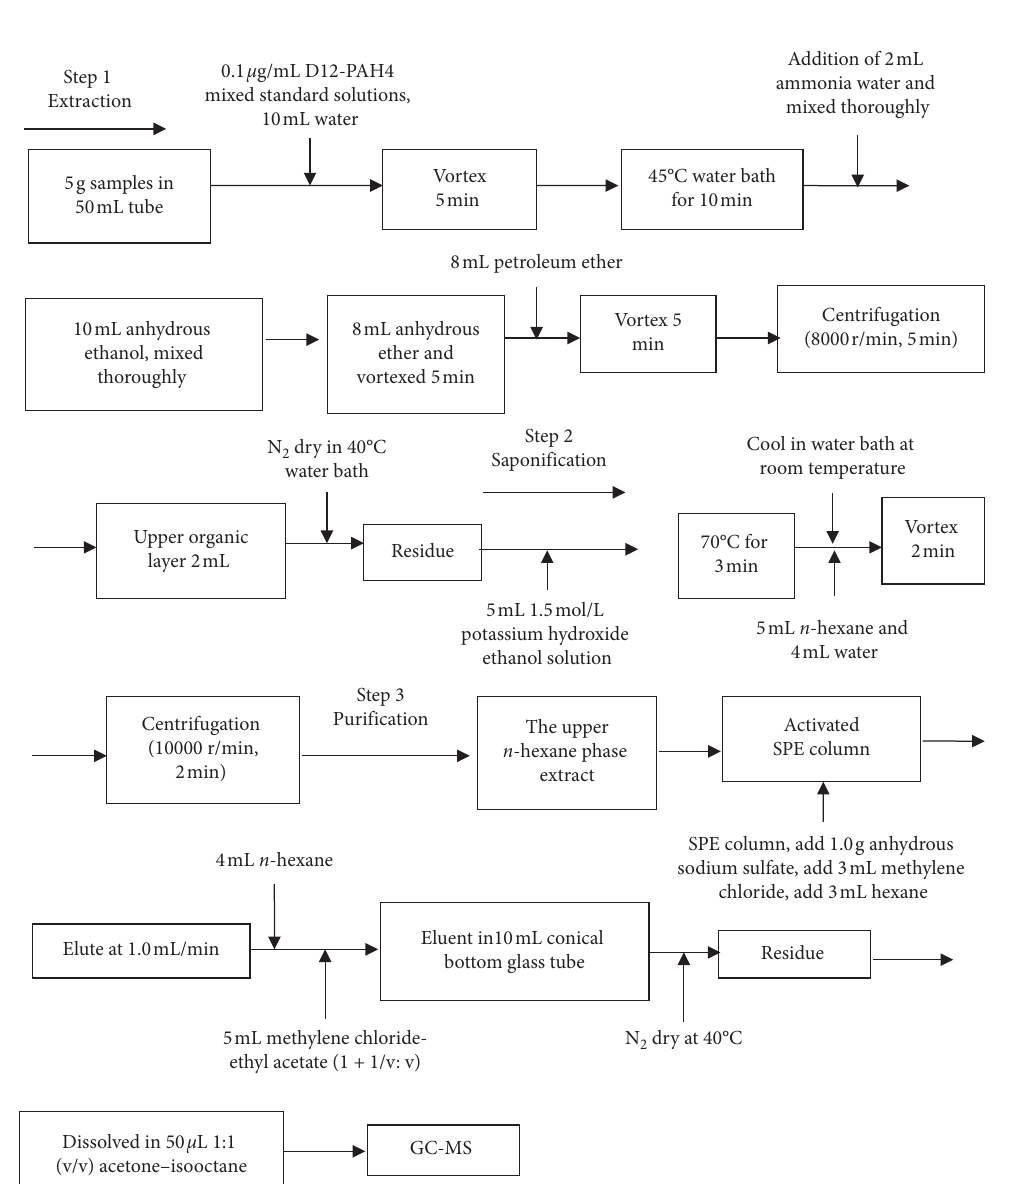
Figure 1: Sample preparation